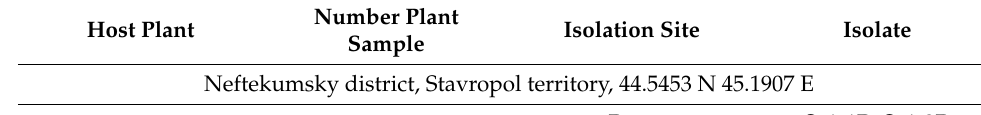
Table 1. Plant samples and isolated strains of